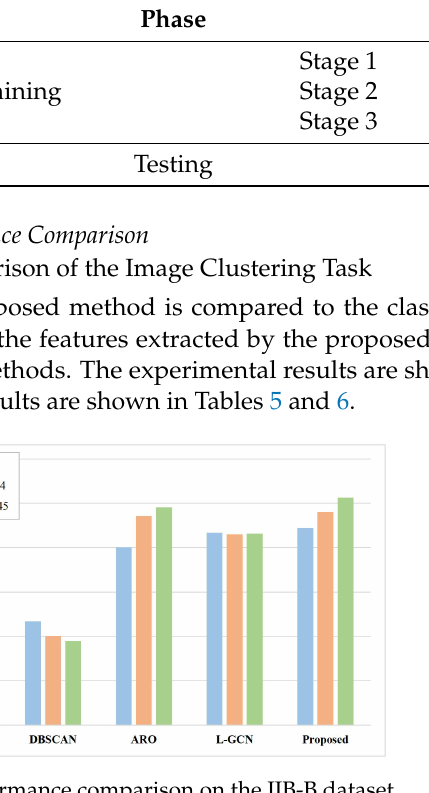
Figure 6. Performance comparison on the IJB-B